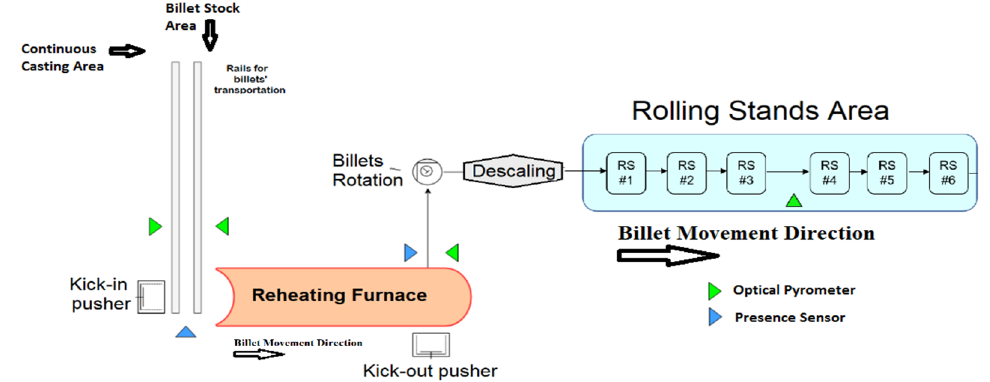
Figure 1. Example of the steel industry subpart related to a billet reheating